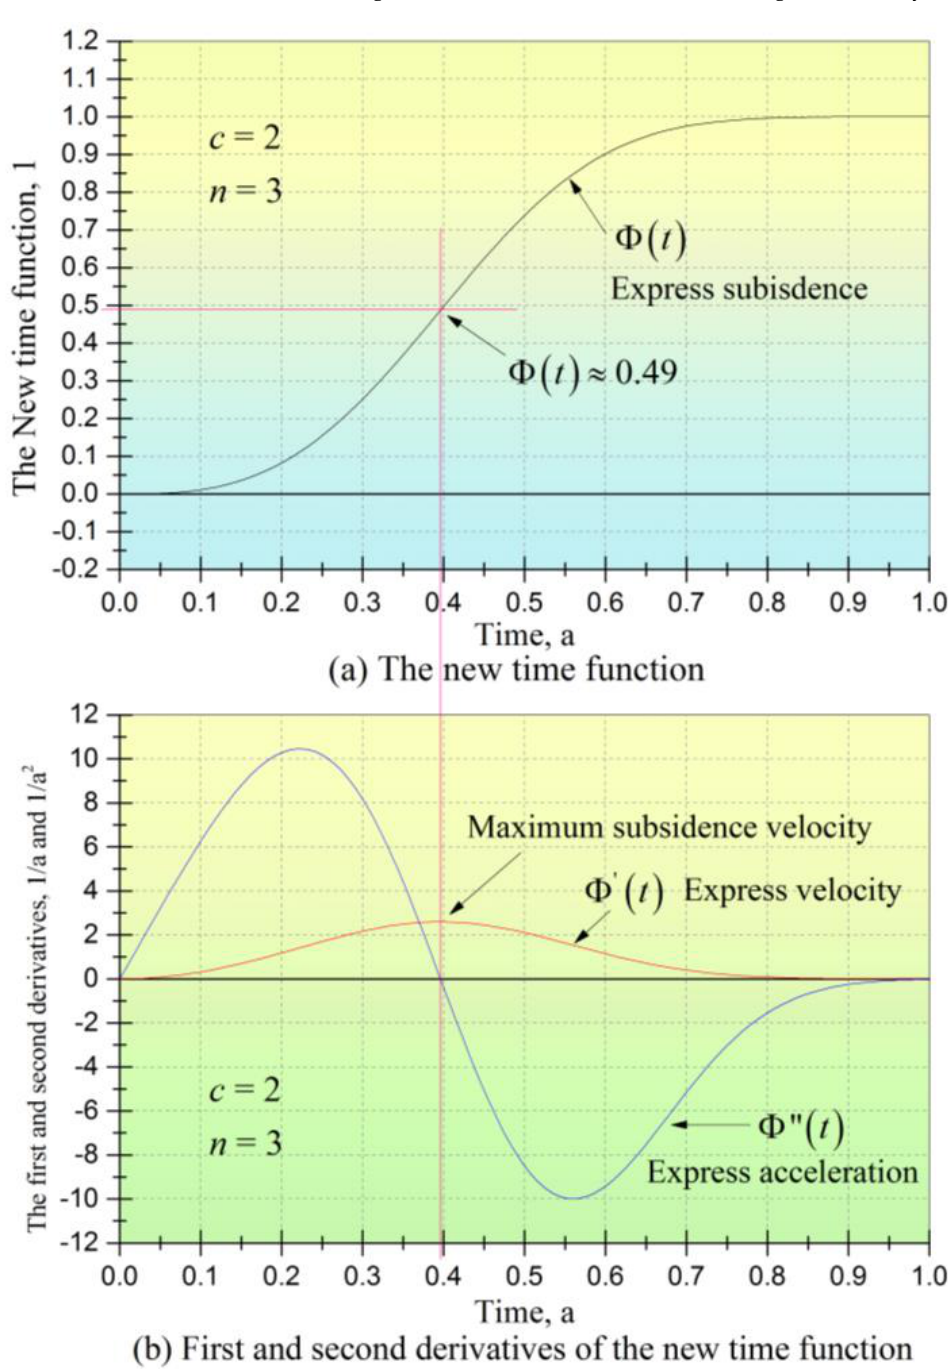
Figure 4. Graphical representation of the new time function and its first and second derivatives. ( a ) The new time function ( b ) First and second derivatives of the new time function.